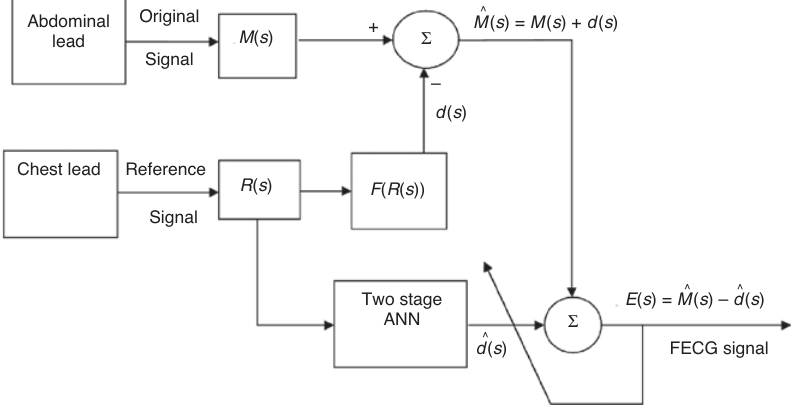
Figure 2: Proposed Adaptive Noise Cancellation